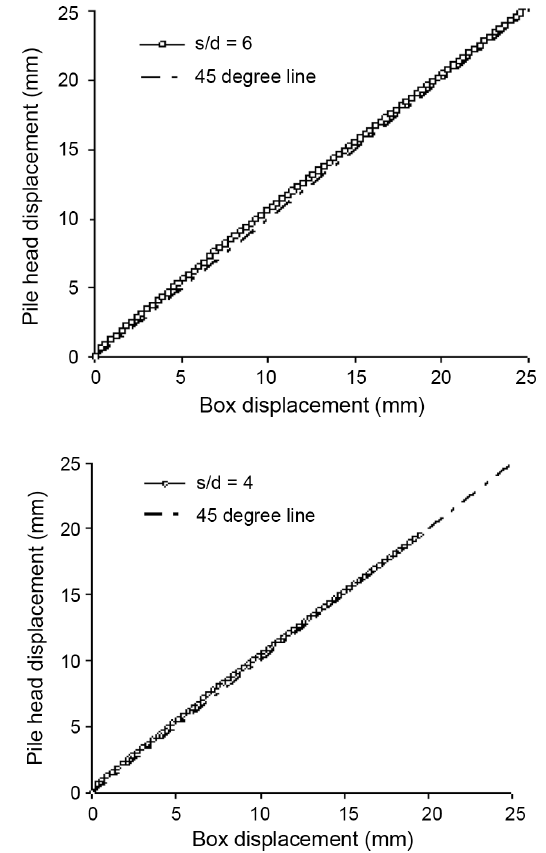
Fig. 6. Pile head displacements versus box displacement